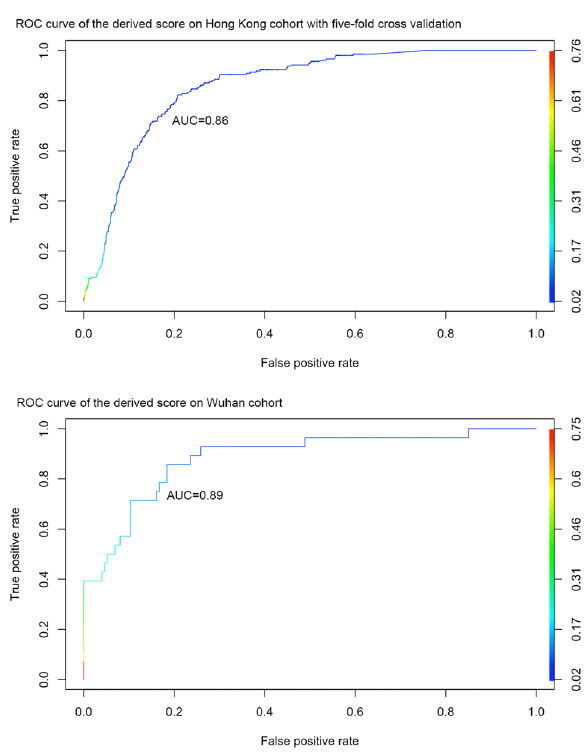
Fig. 3 Receiver operating characteristic (ROC) analysis. ROC curves for classifying composite outcome of COVID-19 patients with dichotomized risk score on Hong Kong cohort ( fi vefold cross- validation) and Wuhan